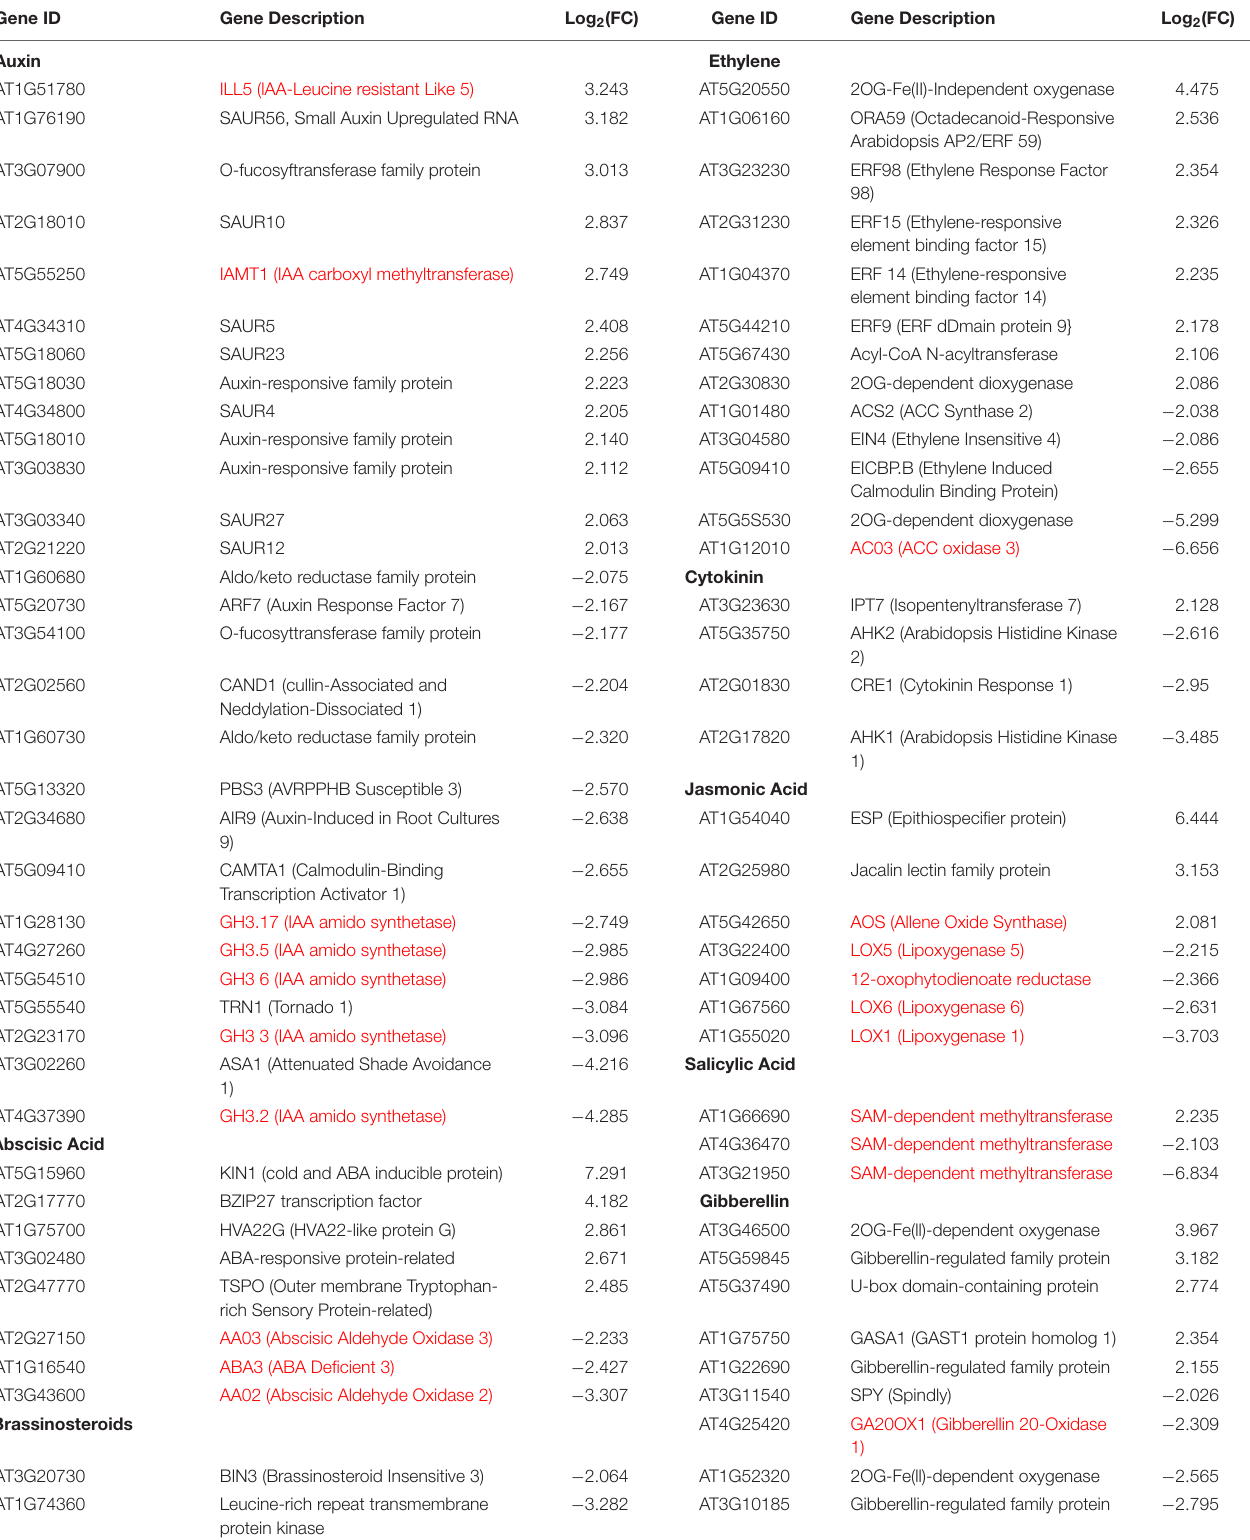
TABLE 1 | Hormone-related genes differentially expressed in iqd1-1 vs. WT plants (FC > 4). Gene ID Gene Description Log 2 (FC) Gene